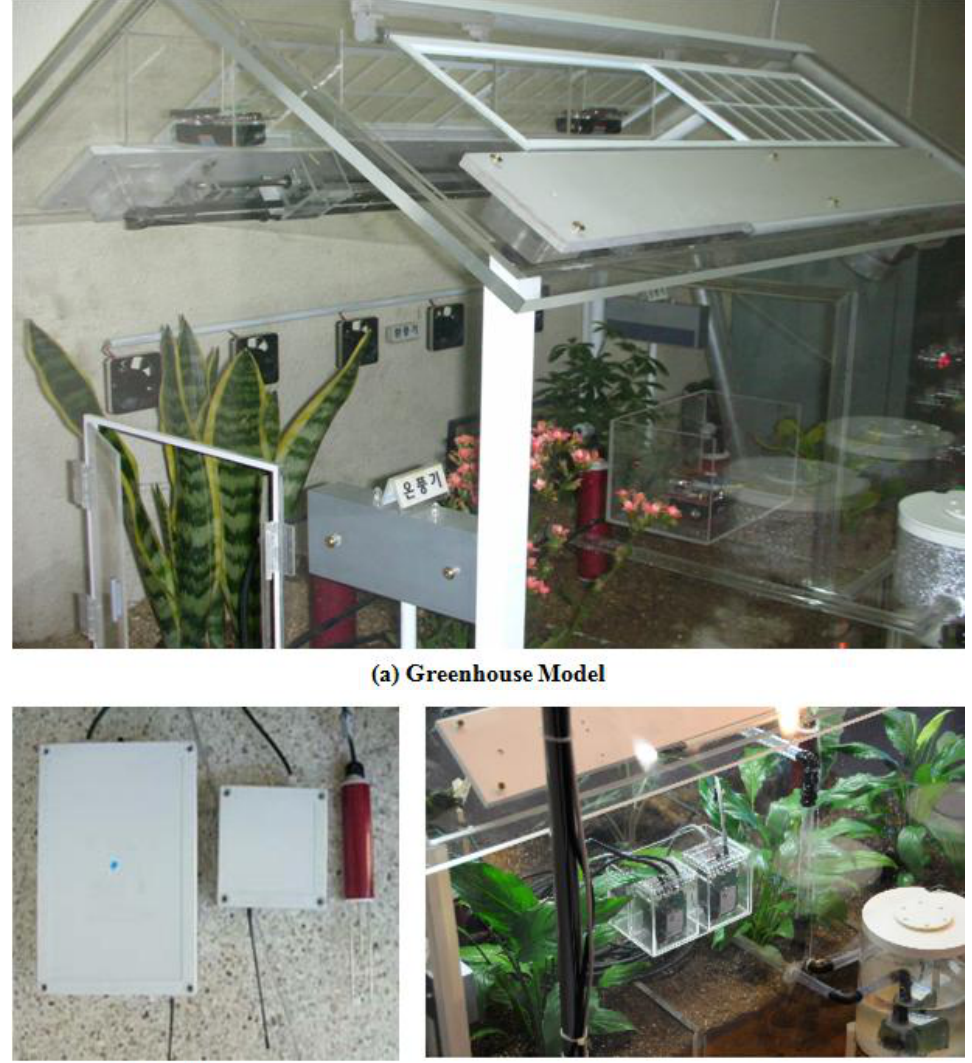
Figure 9. Test-bed: greenhouse model and